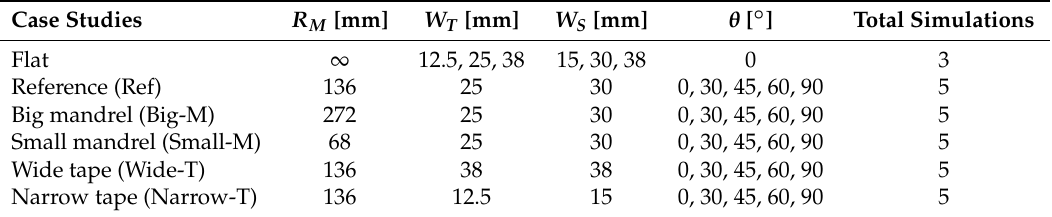
Table 3. Summary of the case studies performed using the developed parametric optical-thermal model.